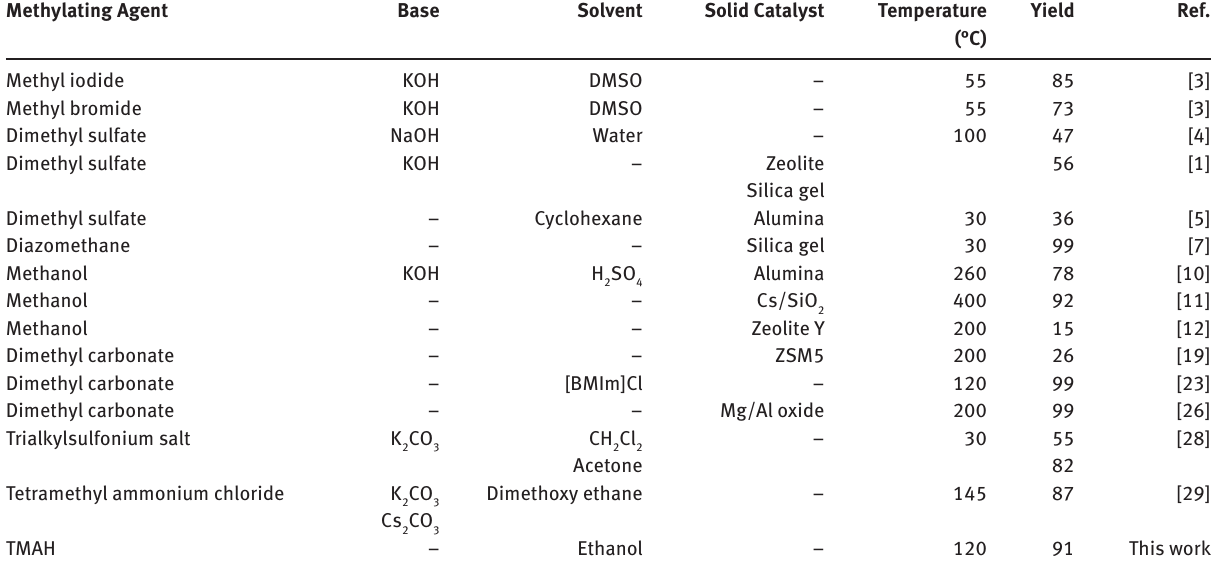
Table 2: Different methods for O-methylation of phenolic compounds. Methylating Agent Base